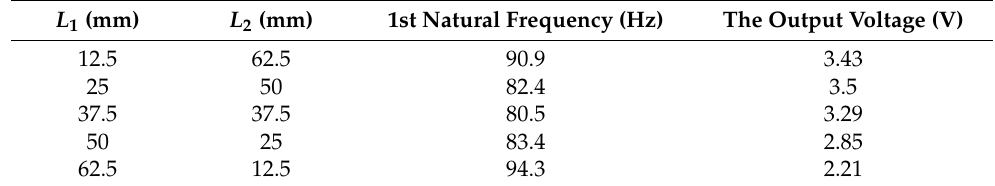
Table 6. The amount of energy harvested in the two-step beam. ( 𝑊 (cid:2869) = 12, 𝑊 (cid:2870) = 36, 𝑊 (cid:2871) = L 1 12 mm ).